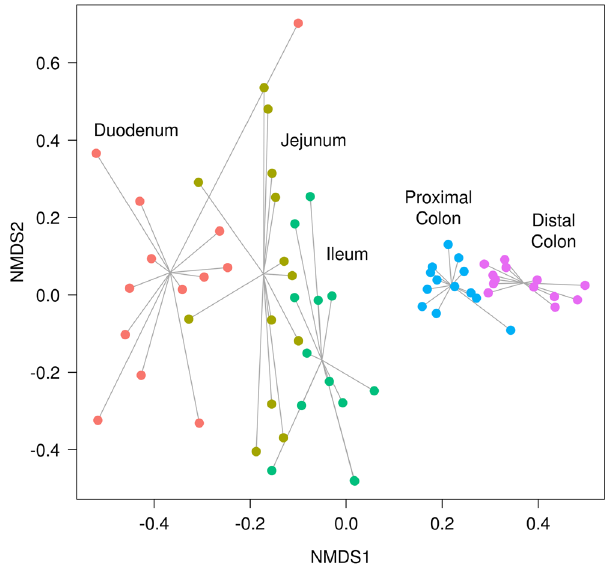
Figure 5. Non-metric multidimensional scaling (NMDS) plot based on Bray-Curtis dissimilarities for the metagenome (KEGG 26 orthologies (KOs) counts) predicted through PICRUSt 25 for the 65 samples from the 13 pigs in each of the 5 intestinal sections (represented by colours). In this plot, it can be seen how the predicted functions for the microbiota of the large intestine sections are more similar among individual pigs, while the predicted functions for the microbiota of the small intestine sections have more variation among individual pigs, meaning that large intestinal microbiotas are more likely to perform similar